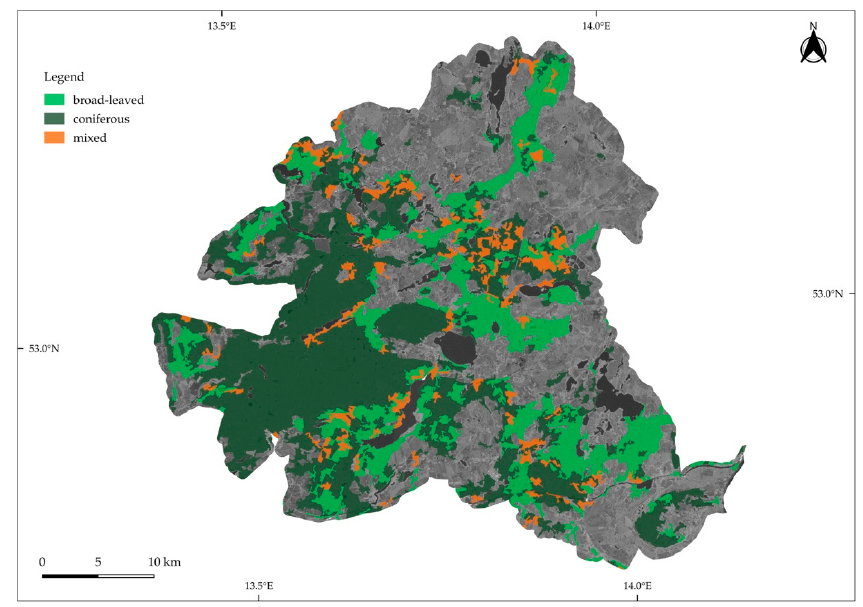
Figure 2. Location of the study site Schorfheide-Chorin. Forest type cover information was taken from the Corine Land Cover Dataset 2018 (© European Union, Copernicus Land Monitoring Service 2021, European Environment Agency).